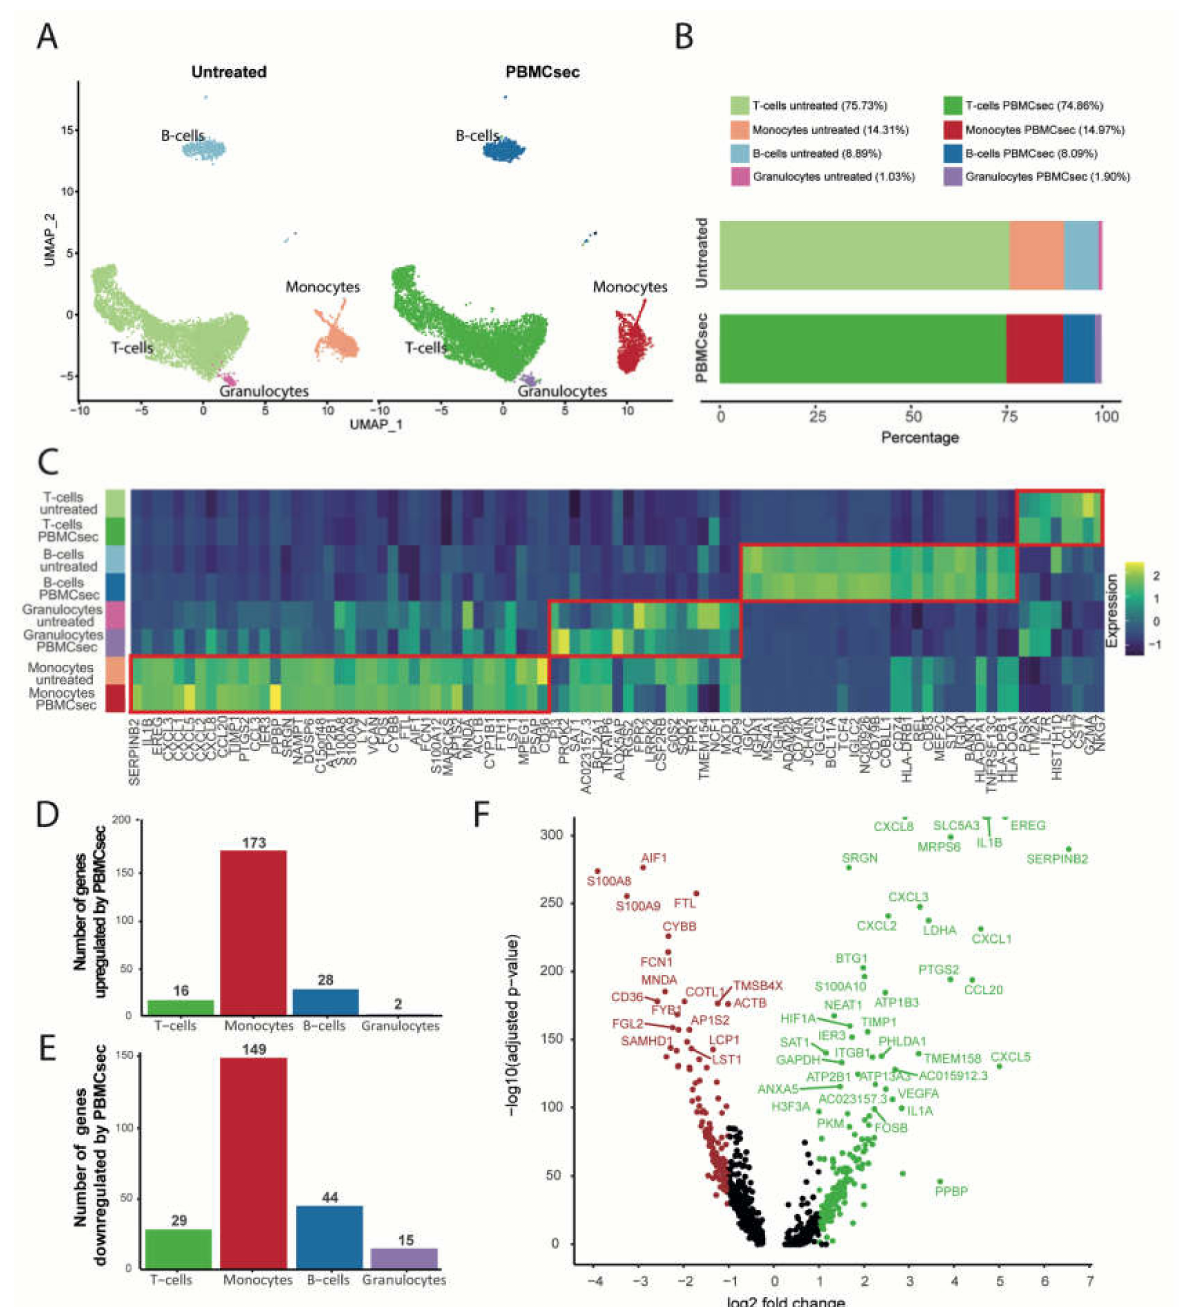
Figure 2. Ex vivo treatment of human whole blood cells alters the transcriptional profile in the monocyte subset and upregulates pathways associated with tissue regeneration. ( A ) UMAP clustering identified T-cells, monocytes, B-cells, and granulocytes in untreated and PBMCsec-treated samples with ( B ) similar cell frequency for each cluster between the investigated conditions. ( C ) Heatmap of cluster-defining marker genes of normalized gene expression showing distinct gene patterns between T-cells, monocytes, B-cells, and granulocytes. Bar plots represent the number of ( D ) up- and ( E ) downregulated genes in PBMCsec-treated samples compared to untreated control. Genes with an adjusted p -value < 0.05 and an average log 2 fold change ≥ 1 or ≤− 1 were considered as DEGs. ( F ) Volcano plot showing the regulated genes in monocytes treated with PBMCsec when compared to untreated monocytes. Upregulated genes are marked in green, while downregulated genes are shown in